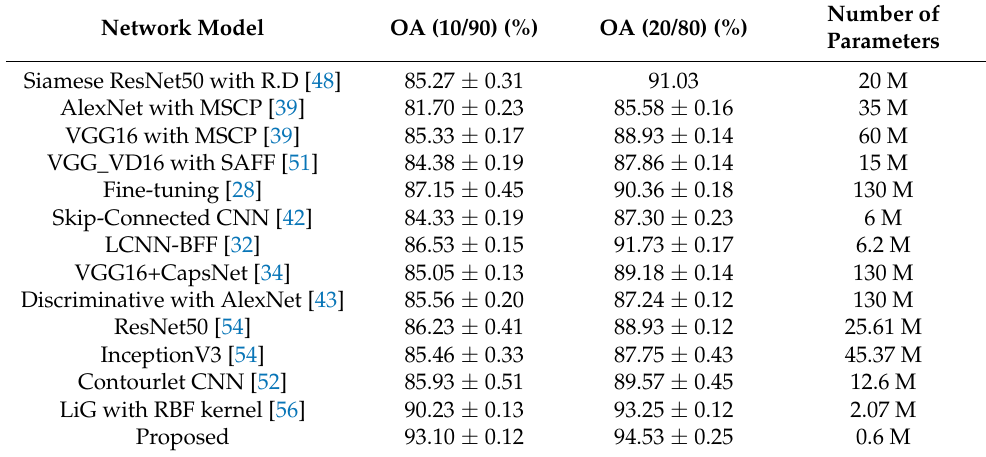
Table 5. Comparison of OA and parameters between the proposed method and some advanced methods on the AID dataset with 10% and 20% training ratio.